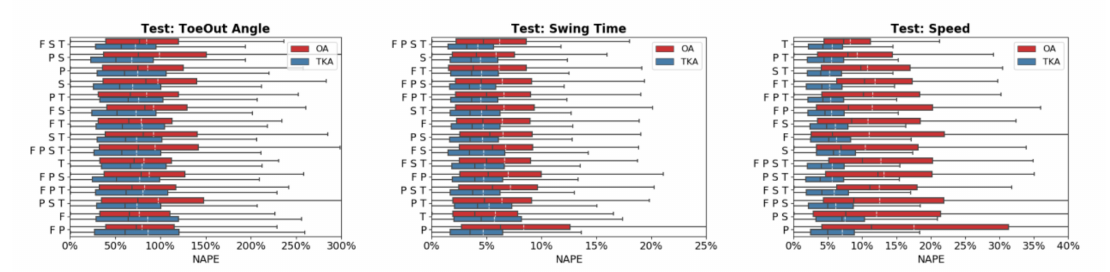
Figure 4. Normalized absolute percentage error (NAPE) of neural network predictions for all gait parameters and various sensors configurations grouped by subject cohort (OA and TKA) in the test set. For each gait parameter, sensor configurations are listed in order of increasing NAPE.